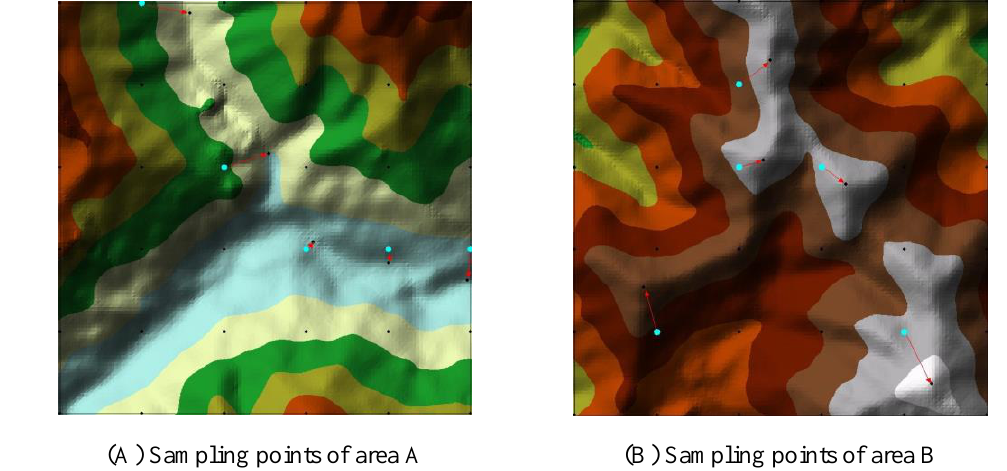
Figure 13. The locations of the sampling points after modification. ( A ) Sampling points before modification of area A; ( B ) Sampling points before modification of area